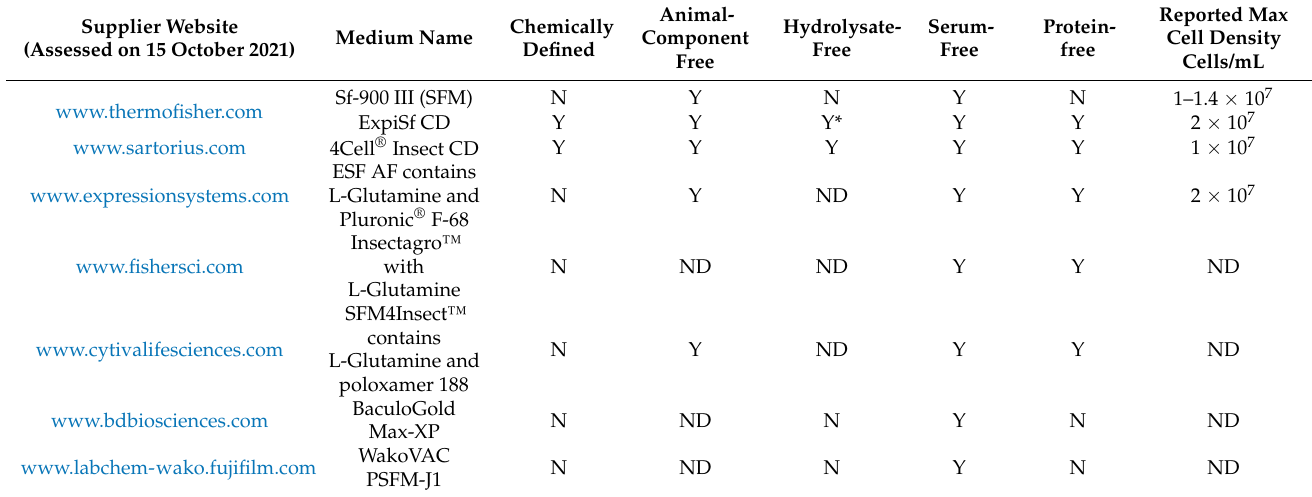
Table 2. A summary of suppliers, media, and their main